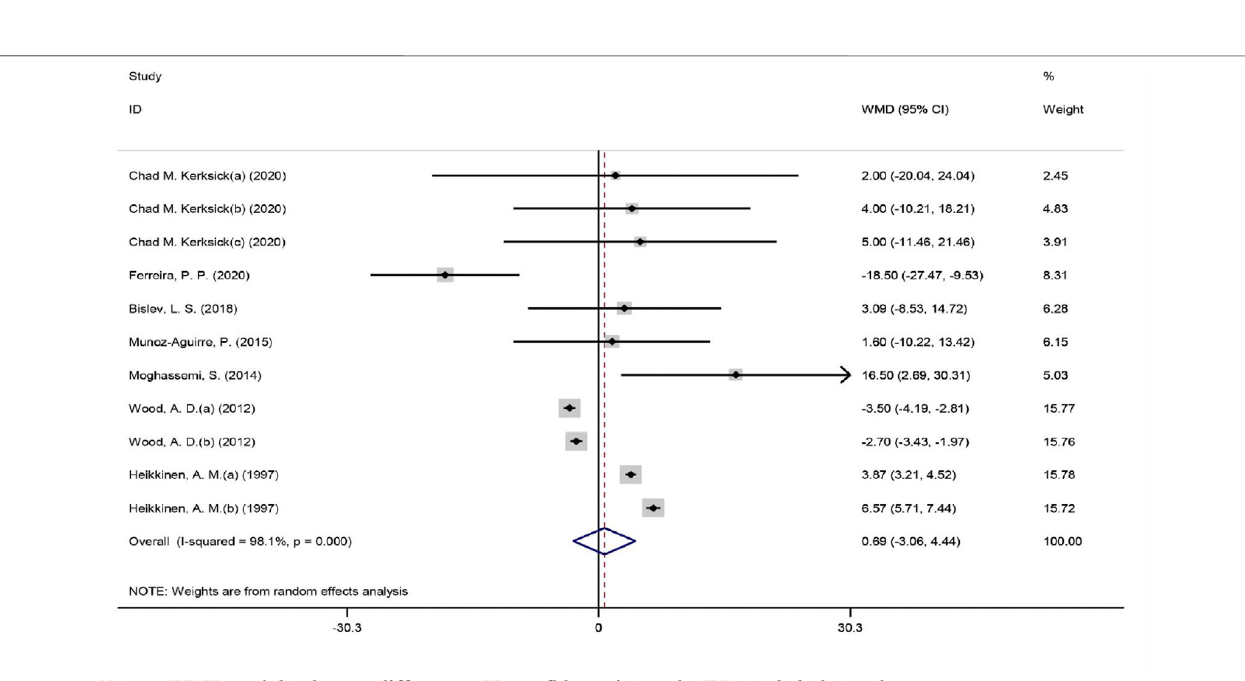
FIGURE 5 | Forest plot of the randomized controlled trials investigating the effects of vitamin D.